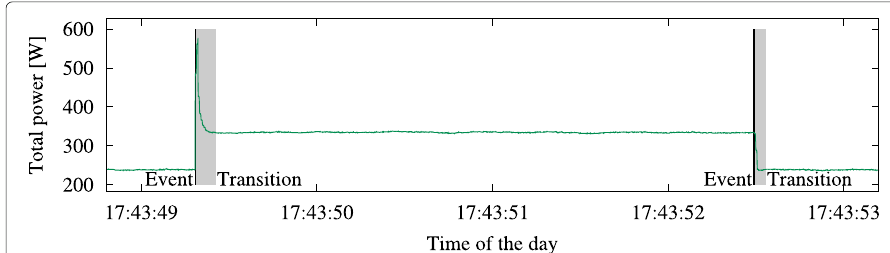
Fig. 2 Excerpt of a power consumption trace with event and transition annotations. Events are marked as solid lines, transitions are marked as grey